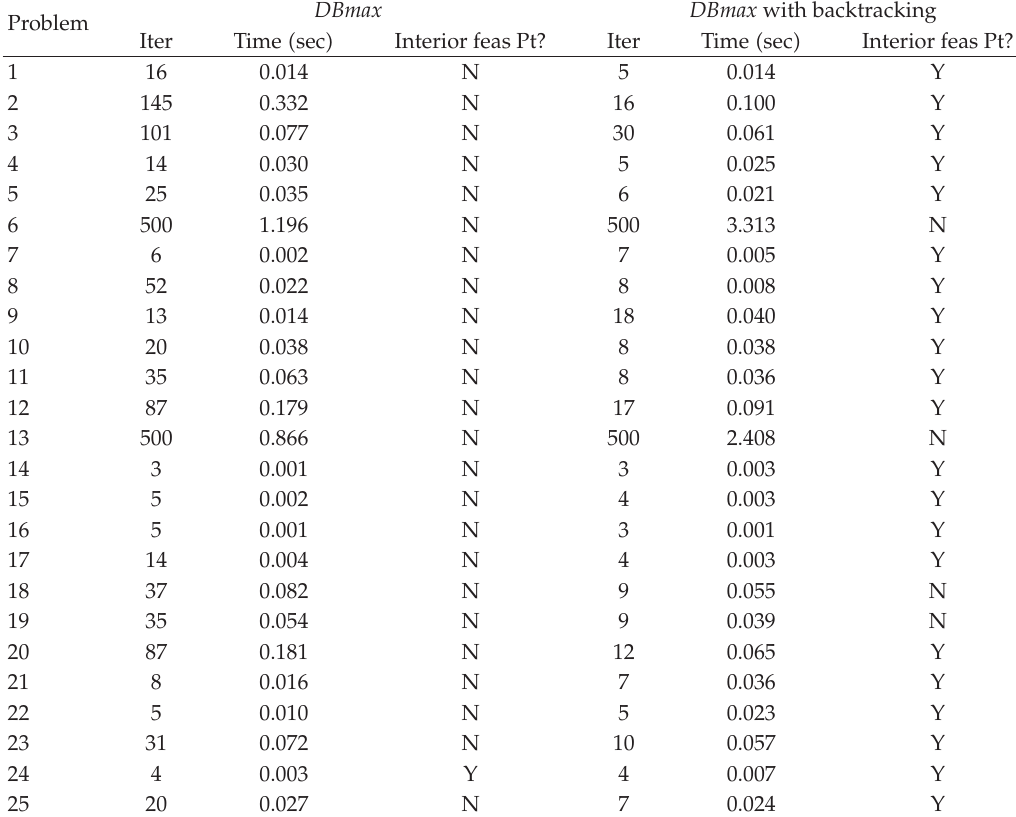
Table 4: SOCs: comparison of DBmax method and DBmax method with backtracking.